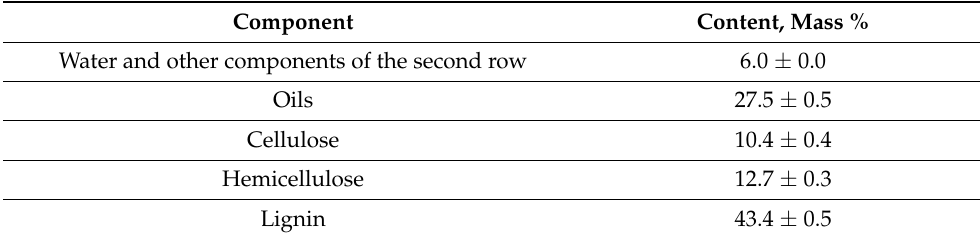
Table 1. Summary of the results of the chemical analysis of the filler